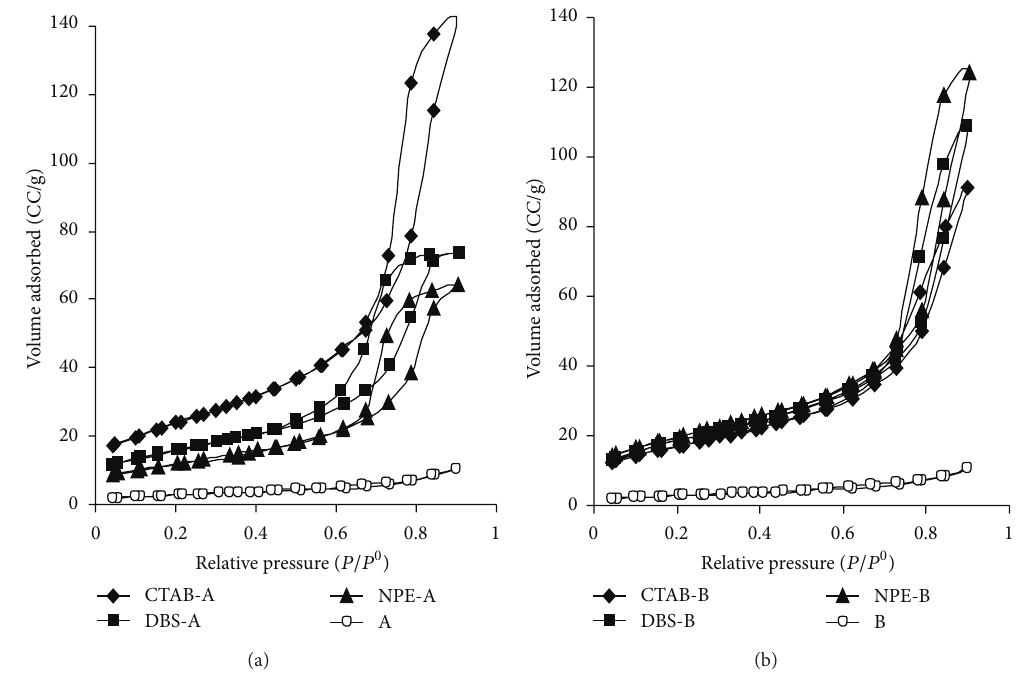
Figure 6: N 2 adsorption/desorption isotherms for the